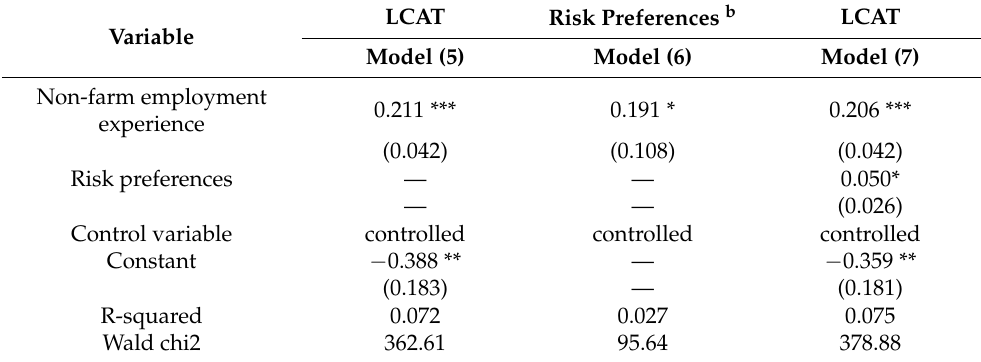
Table 4. Mechanism test of non-farm employment experience on grain farmers’ LCAT adoption. Variable